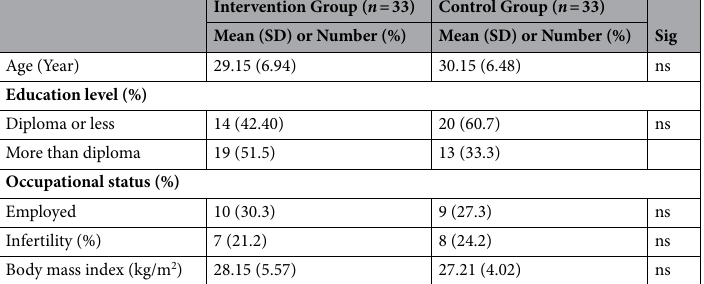
Intervention Group ( n = 33) Control Group ( n =